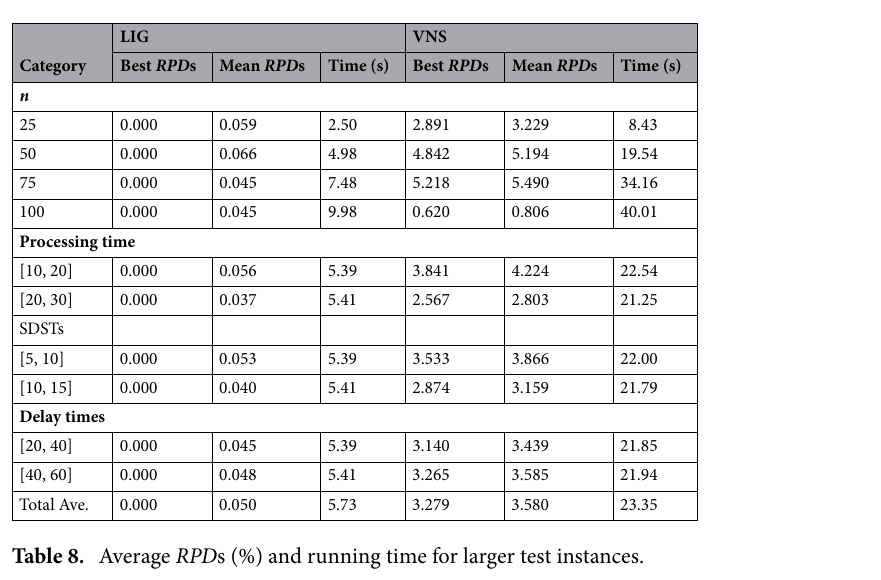
Table 8. Average RPD s (%) and running time for larger test instances.